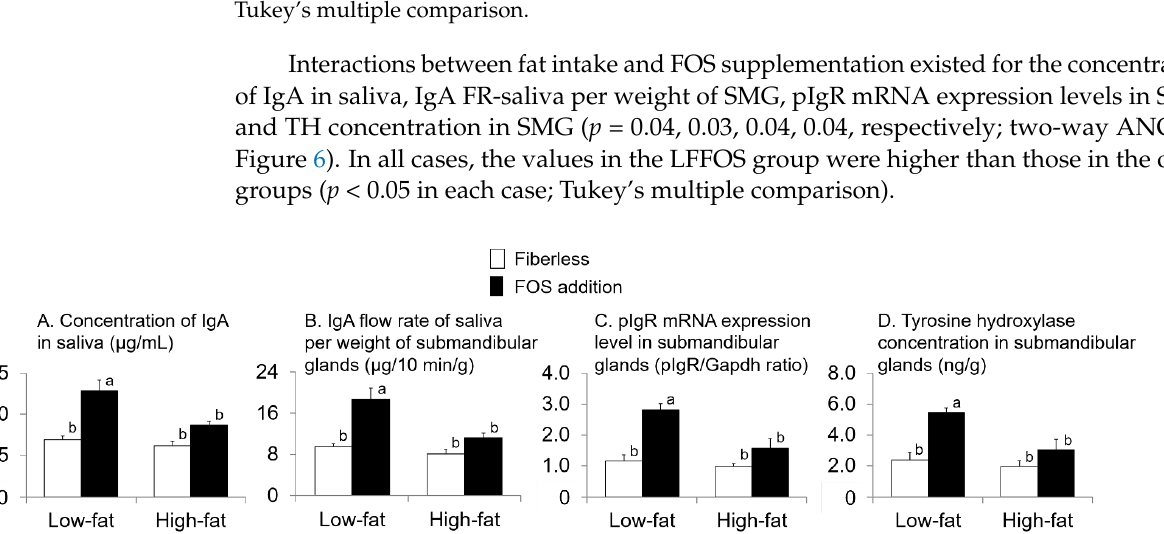
Figure 6. Effects of fat intake and fructo-oligosaccharide (FOS) supplementation on the concentration of IgA in saliva ( A ), IgA flow rate of saliva (IgA FR-saliva) per weight of submandibular glands (SMG) ( B ), polymeric immunoglobulin receptor (pIgR) mRNA expression level in SMG ( C ) and tyrosine hydroxylase (TH) concentration in SMG ( D ). Values are Means ± SEM. n = 8 per group. two-way ANOVA. Values with different superscript letters are significantly different ( p < 0.05); Tukey’s multiple comparison.